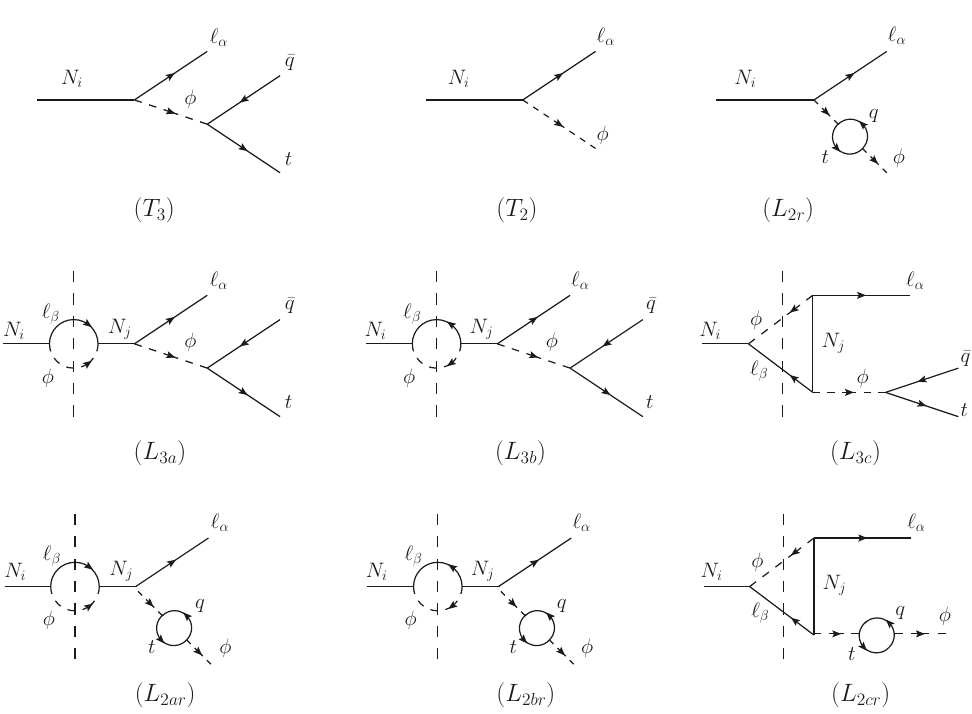
Figure 3 . Some of the diagrams contributing to the CP asymmetry in two- and three-body decays (cid:0) (cid:1) at (cid:21) 2 . The vertical dashed lines indicate the possible cuts to obtain an imaginary t O